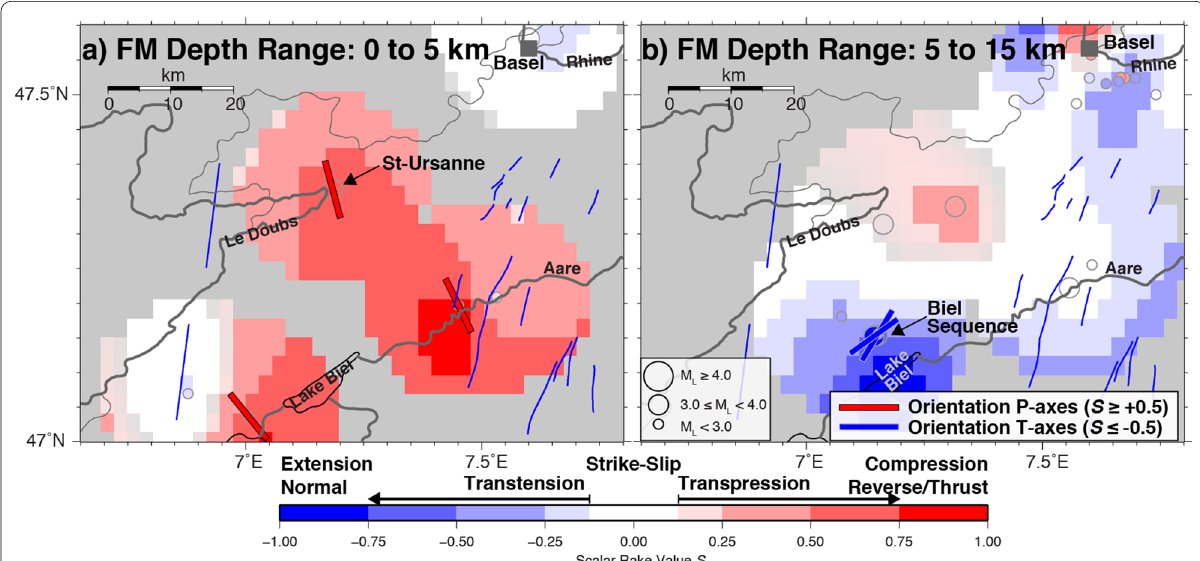
Fig. 14 Regionalization of the deformation in the northern Jura FTB ( S parameter, based on the rake angle, see text) for two different depth intervals within the upper crust. a Uppermost crust (0–5 km). b Upper to mid-crustal depths (5–15 km). The colour code corresponds to the type of deformation (compression in red, extension in blue, strike-slip in white). Circles are observed focal mechanism (FM) color-coded according to the S values, same as the interpolated grid in the background. The orientation of T-axes for extensional and the orientation of the P-axes for compressional focal mechanisms are also shown with blue and red lines,